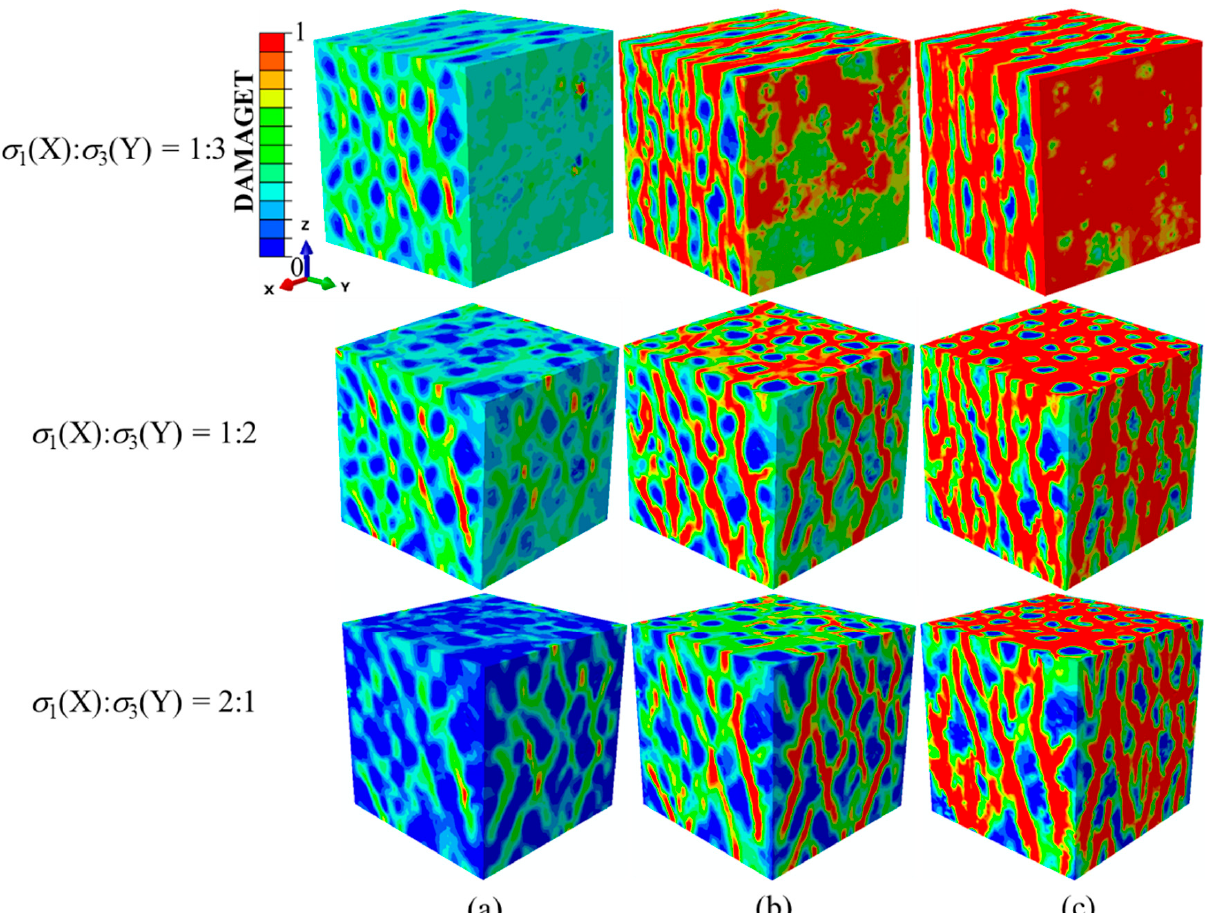
Figure 13. Damage evolution process and failure patterns with different σ 1 / σ 3 ratios when σ 1 (X)/f c = 0.02 ( a ) at the peak stresses, ( b ) further damage evolution and ( c ) complete failure of the specimens. DAMAGET denotes damage due to tension.